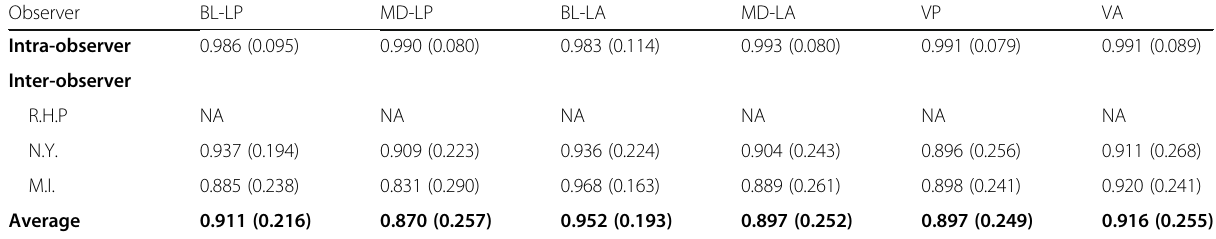
Table 4 Intra- and inter-observer measurement reliabilities and TEM for implant placement accuracy parameters